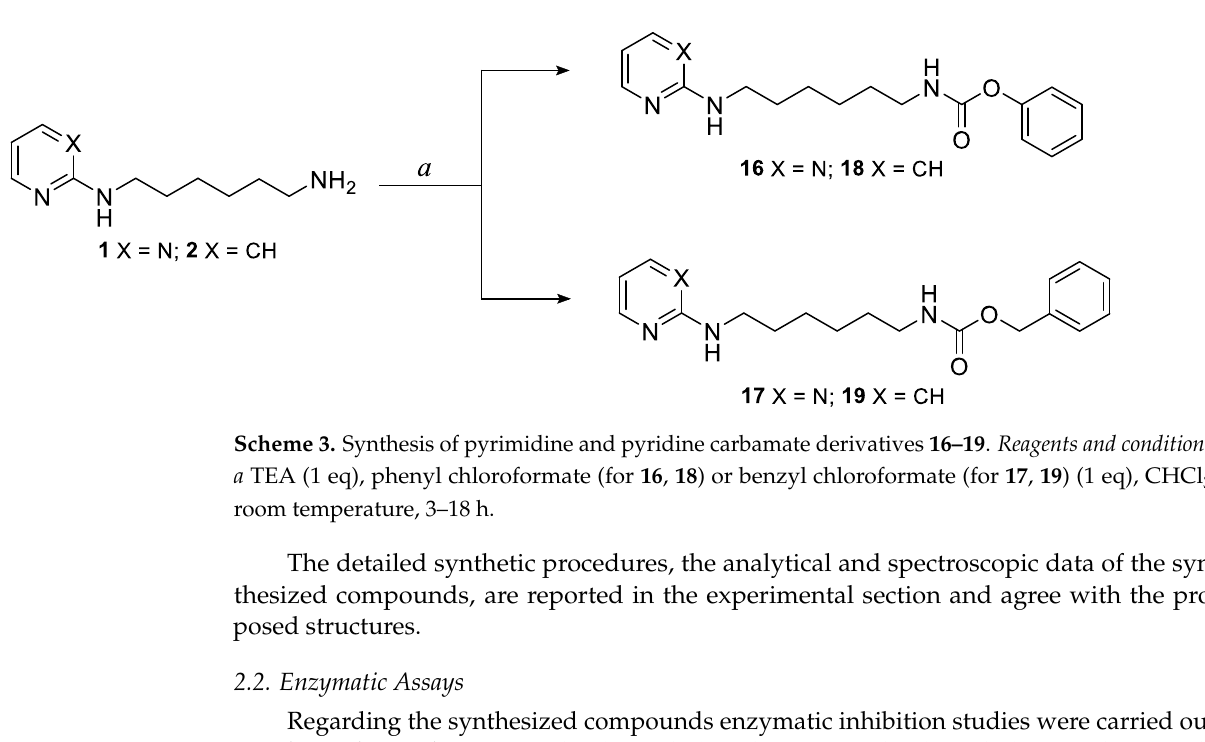
Table 1. Inhibition of Ee AChE and eq BChE activities by pyrimidine and pyridine amide derivatives 3 – 15